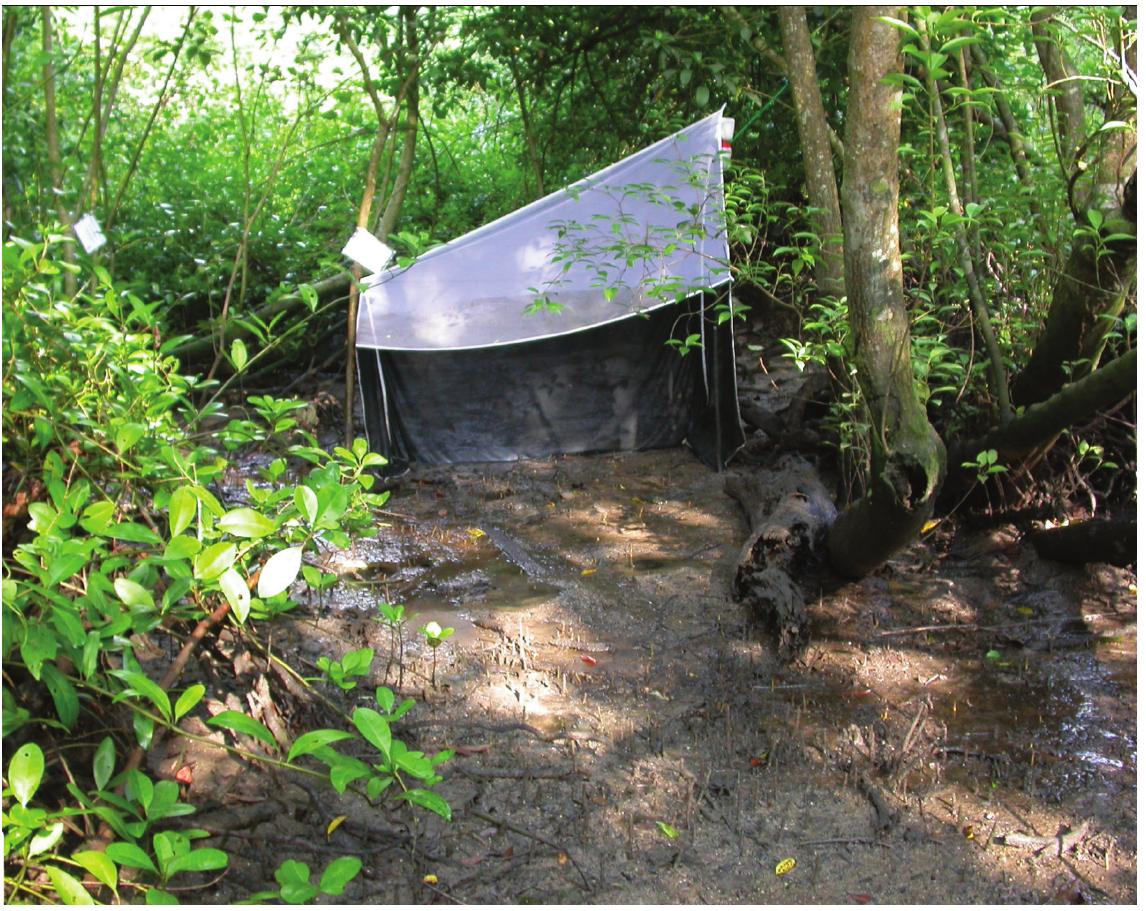
Fig. 7. Malaise trap in a mangrove swamp, habitat of Eupetersia singaporensis sp. nov., Kranji Nature Trail (Sungei Buloh),